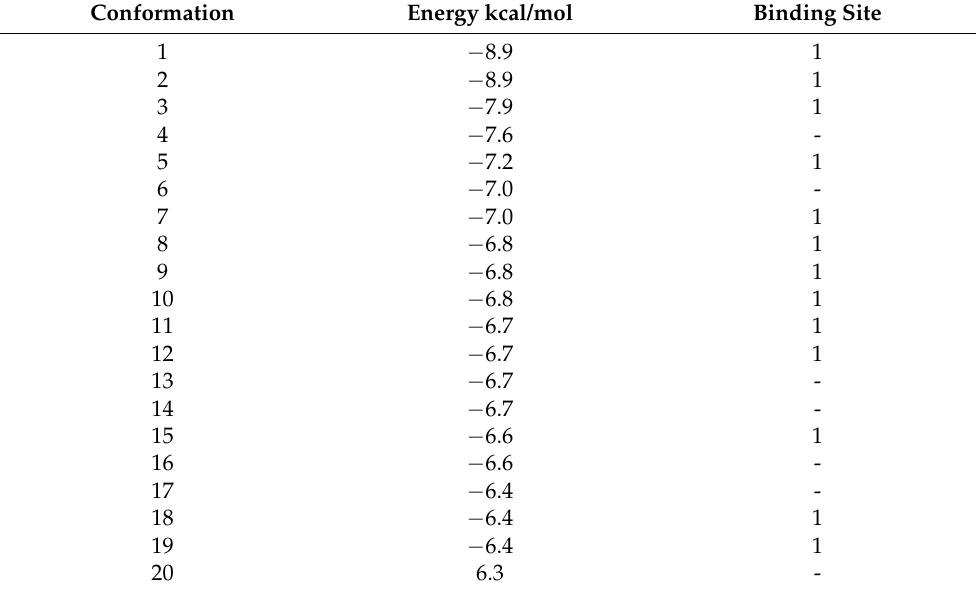
Table 6. Binding energy values for each conformation generated by the blind molecular docking for the β -caryophyllene. As a reference in this work, the A740003 allosteric site is named site 1, and the ATP binding site is named site 2. In addition, a few confirmations were docked in aleatory non-pocket positions in the P2XR, which were not considered a potential binding site.